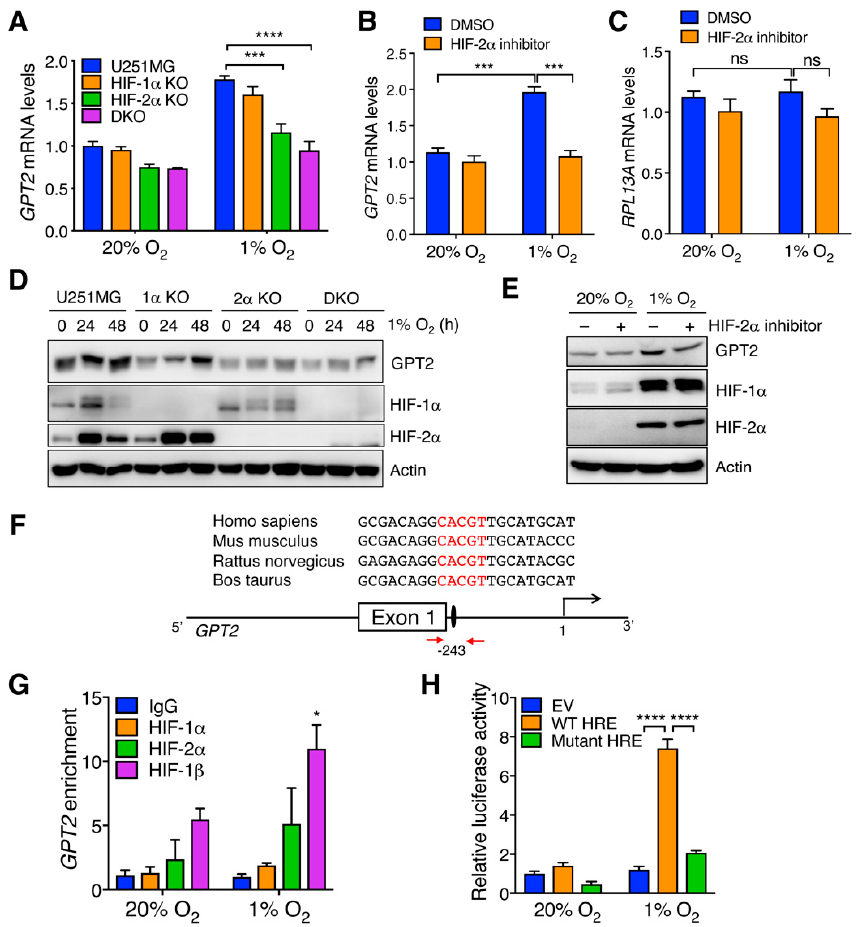
Figure 2. GPT2 is a direct HIF-2 target gene. ( A ) qRT-PCR analysis of GPT2 mRNA in parental, HIF-1 α KO, HIF-2 α KO, and HIF-1/2 α DKO U251MG cells exposed to 20% or 1% O 2 for 24 h (mean ± SEM, n = 3). *** p < 0.001, **** p < 0.0001 by two-way ANOVA with Tukey’s test. ( B , C ) qRT-PCR analysis of GPT2 ( B ) and RPL13A ( C ) mRNA in U87MG cells exposed to 20% or 1% O 2 for 24 h in the absence or presence of HIF-2 α inhibitor (mean ± SEM, n = 3). *** p < 0.001 by two-way ANOVA with Tukey’s test. ns, not significant. ( D ) Immunoblot analysis of indicated proteins in parental, HIF-1 α KO, HIF-2 α KO, and HIF-1/2 α DKO U251MG cells exposed to 20% or 1% O 2 for 24 or 48 h. ( E ) Immunoblot analysis of indicated proteins in U87MG cells exposed to 20% or 1% O 2 for 24 h in the absence or presence of HIF-2 α inhibitor. ( F ) The scheme of the human GPT2 HRE. The nucleotide sequences of the HRE (shown in red) from human, mouse, rat, and bovine are shown on the top. The transcription start site is designated as 1. Exon and intron are not drawn to scale. Red